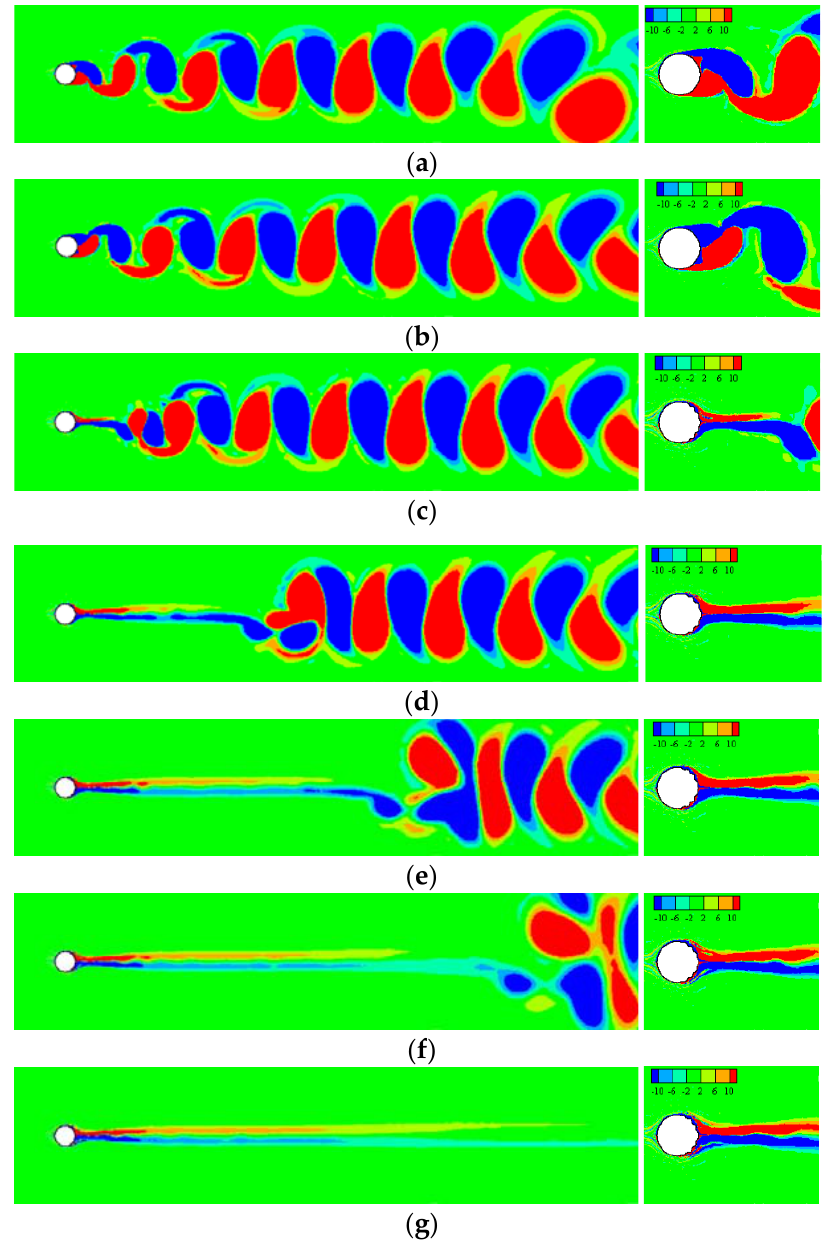
t = 2.16 s. ( d ) t = 2.31 s. ( e ) t = 2.46 s. ( f ) t = 2.61 s. ( g ) t = 2.97